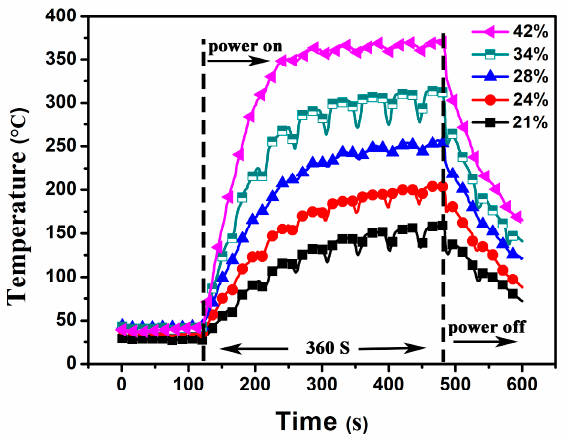
Figure A1. Annealing temperature curve of the actual sample after calibration. Table A1. Temperature deviation in microwave annealing.